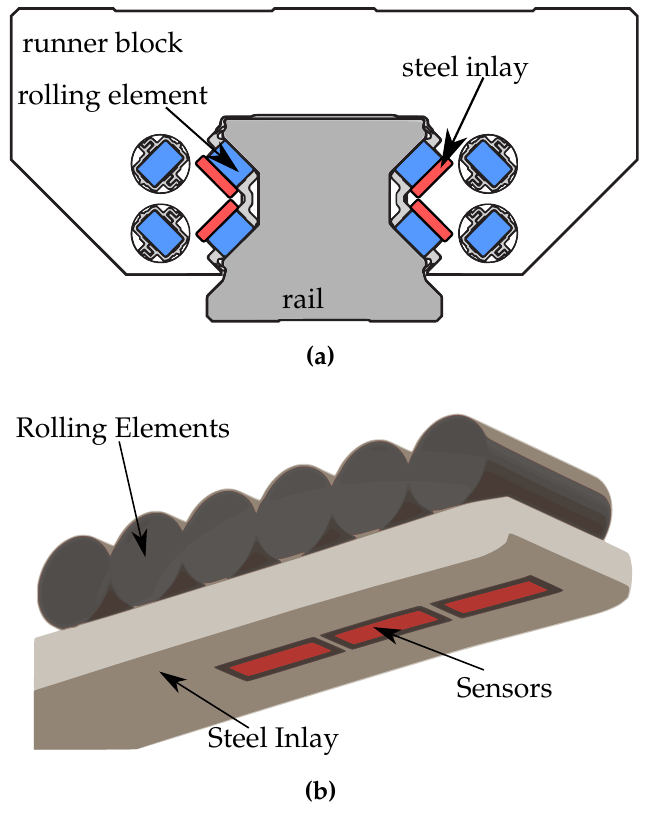
Figure 2. (a) Position of steel inlays (red) below the rolling elements (blue) inside the roller runner block, depiction from [17] (modified). (b) Sketch of the sensor position on the steel inlay (red).